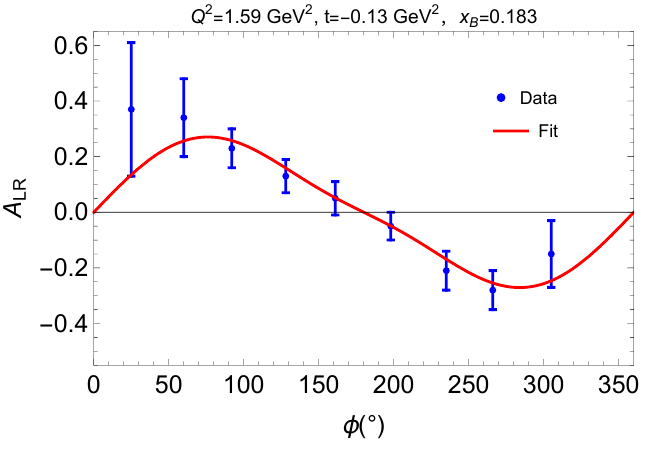
Figure 5. The result of fitting eq. (4.6) to one particular bin of data from